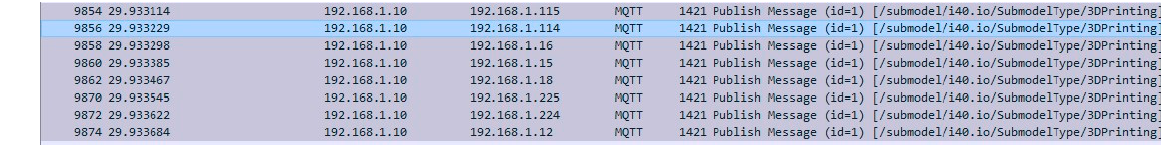
Figure 13. The CfPs from the products to the 3D printers.